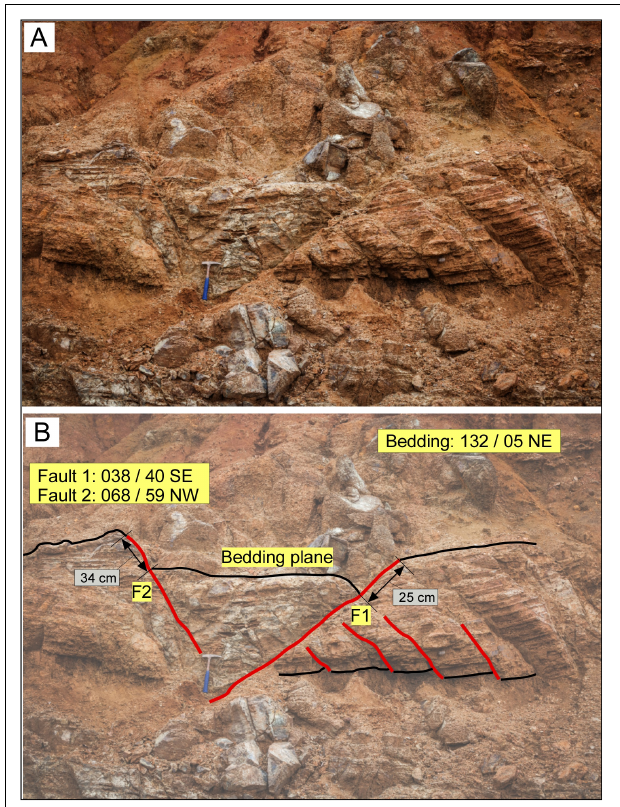
FIGURE 5 | The field photograph shows evidence of normal faulting in Ranau region, Sabah. The un-interpreted (A) field photograph is interpreted below (B) and shows the rock sequence is cut through by the two prominent NW and SE dipping normal fault systems. The faults are older, and have not pierced through younger lithology.